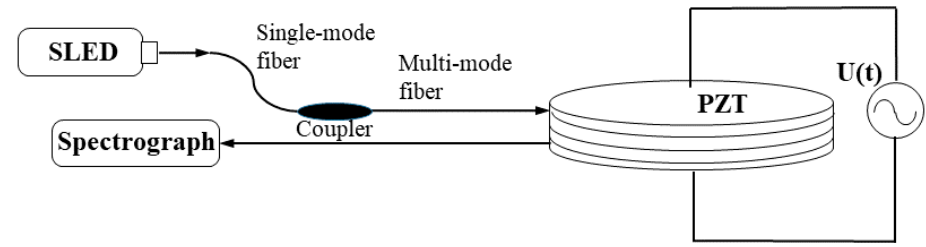
Figure 10. Schematic of a fiber phase modulator based on the piezoelectric ceramic transducer.